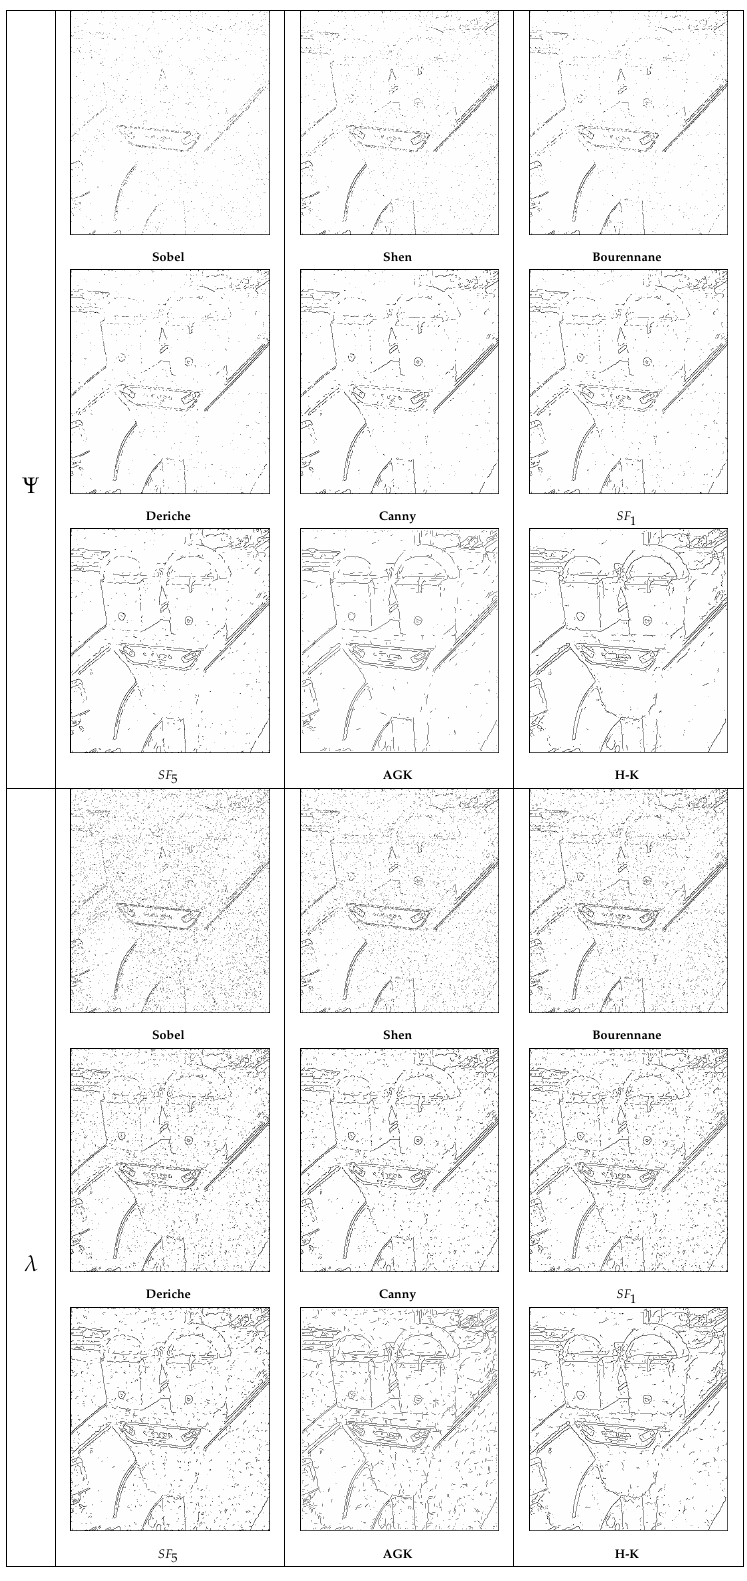
Figure 47. Ideal segmentations for several edge detectors on image parkingmeter, PSNR = 14